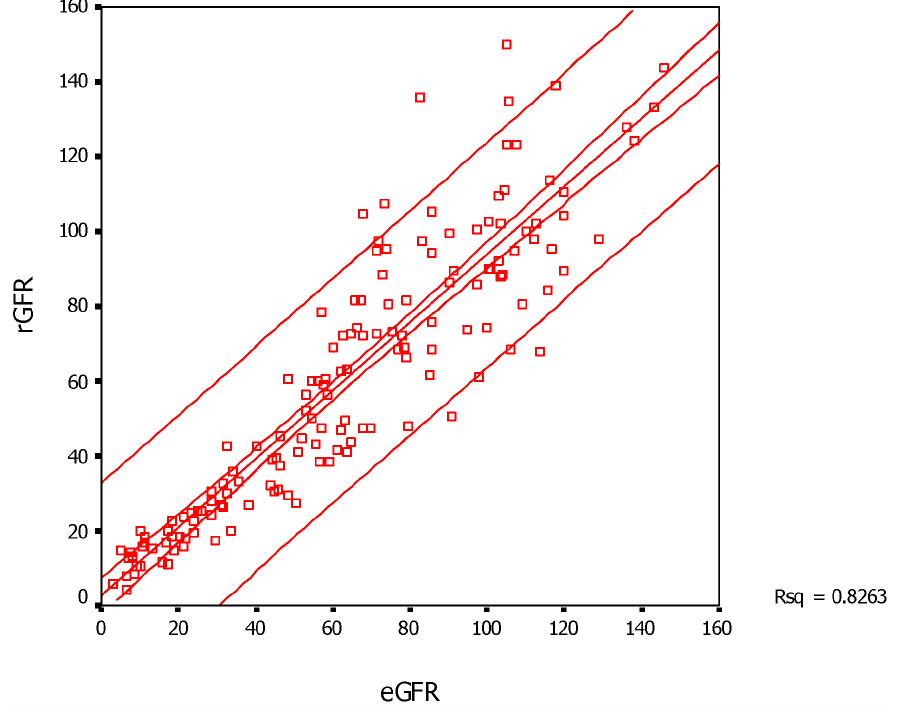
Figure 2. The scatter plot and linear regression of tGFR versus eGFR in 149 subjects. The center line represents the regression line and the surrounding lines show the 95% confidence interval of tGFR for a given eGFR. Abbreviations: eGFR- the GFR estimated by CDK-EPI equation method, tGFR- the GFR measured by dual plasma sampling method.